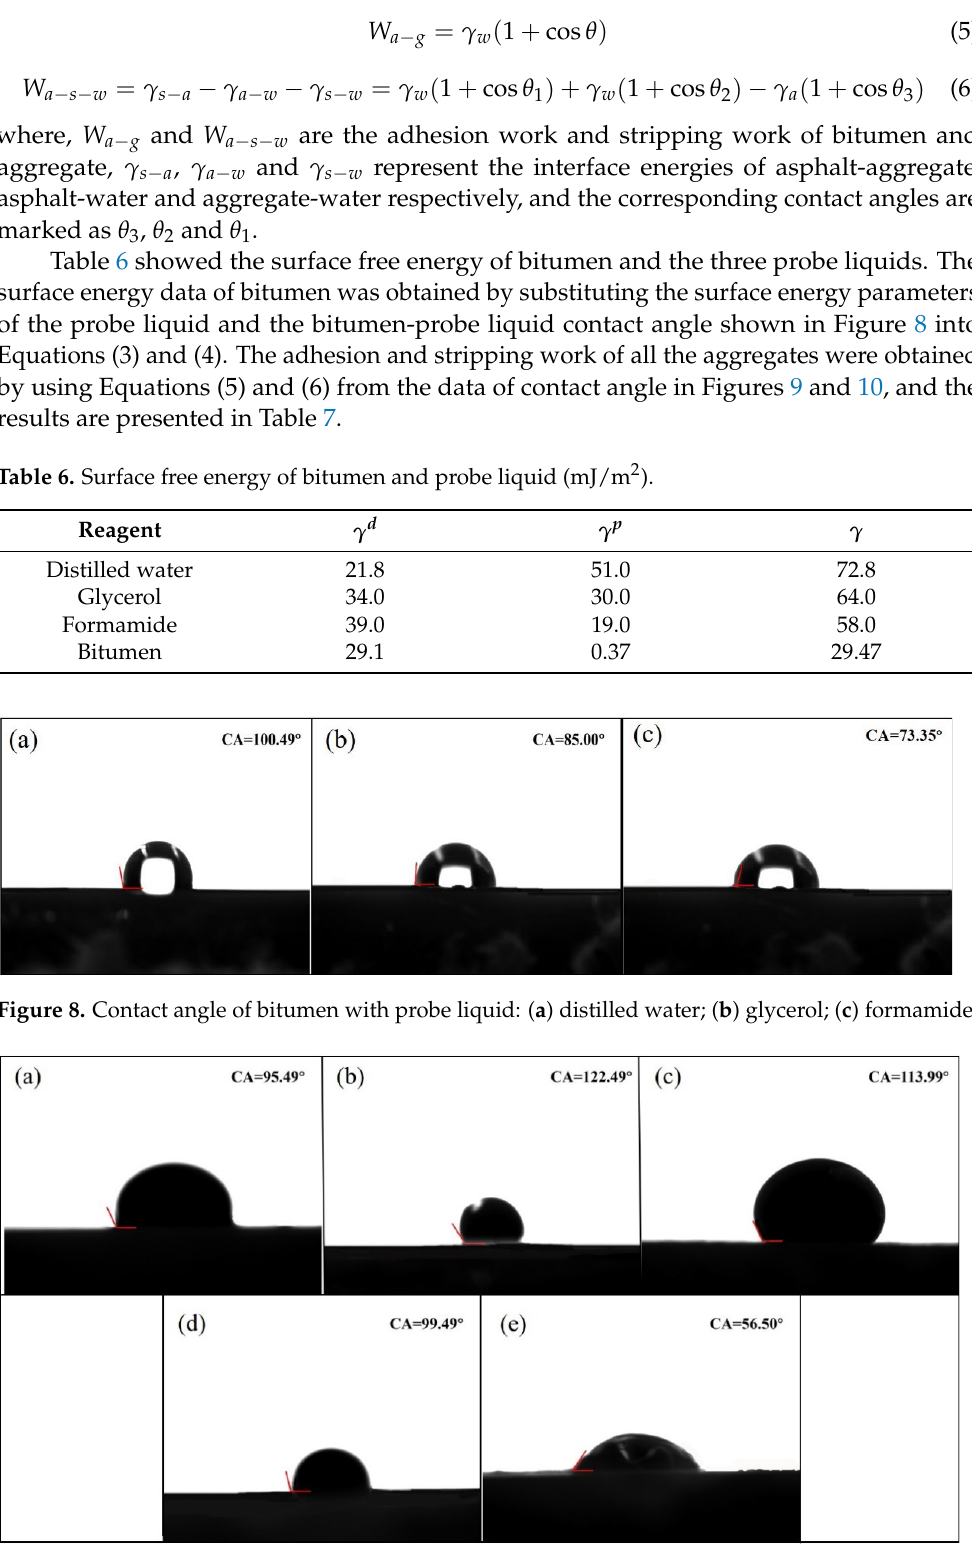
Figure 9. Contact angle of bitumen with aggregates: ( a ) limestone; ( b ) diorite; ( c ) diabase; ( d ) SSA; ( e ) PSSA.